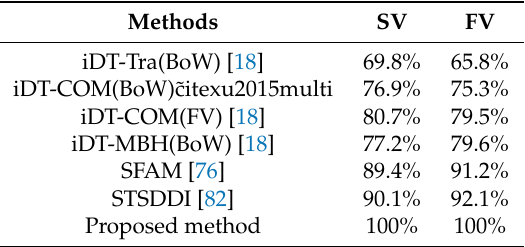
Table 10. Comparison of the proposed method with other methods on the M 2 I dataset for the single task scenario (learning and testing in the same view).